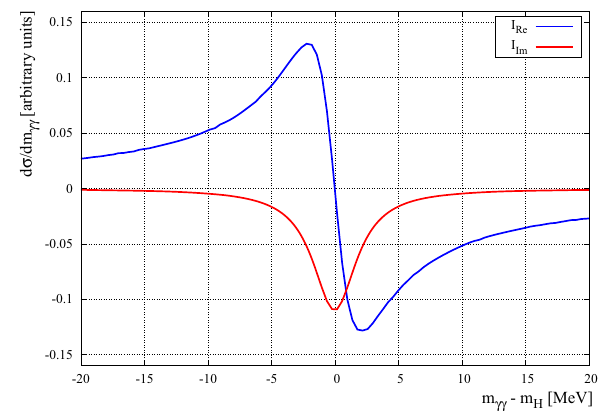
Fig. 1 Real and imaginary parts of the signal-background interference terms, see text for details. This figure is just for illustration purposes.